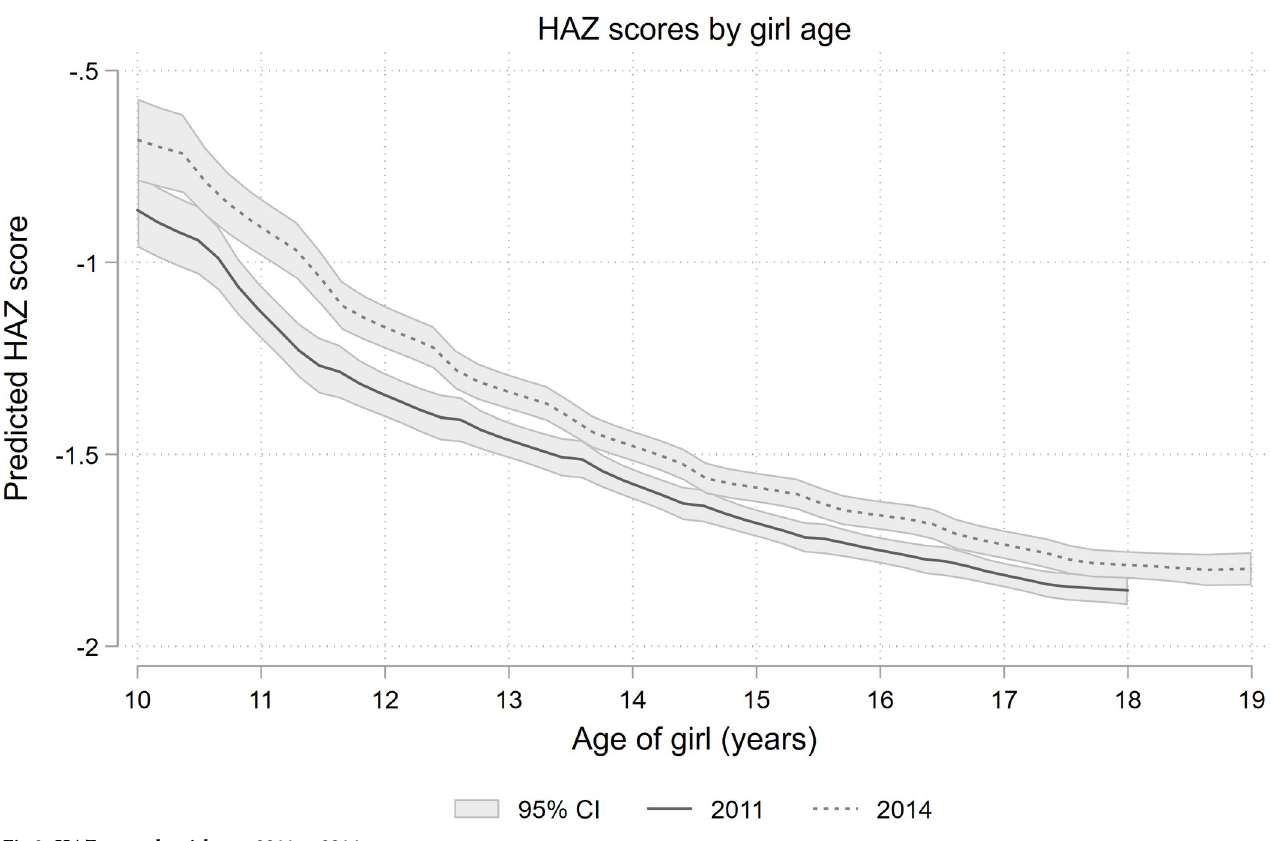
Fig 2. HAZ scores by girl age– 2011 vs 2014.